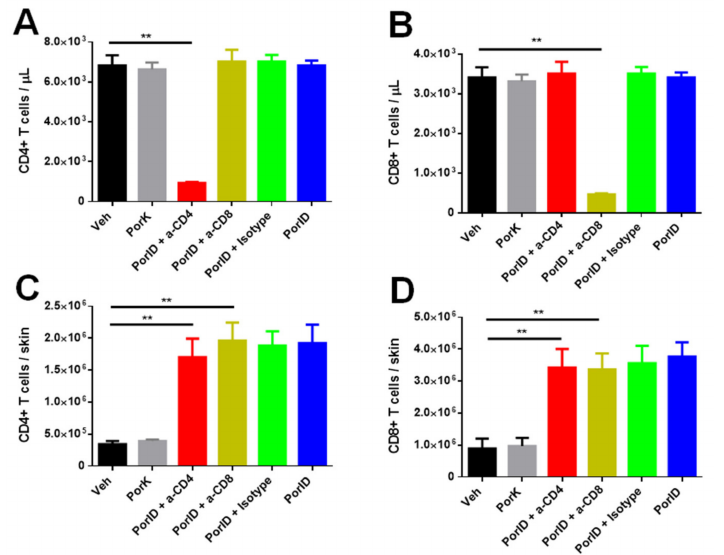
Figure A4. Only circulating memory but not resident memory CD4+ and CD8+ T cells are depleted using GK1.5 and TIB-210 antibodies. C57BL/6J mice were injected with porins intradermally at day 0 and with a homologous boost at day 14. Mice were divided into 4 conditions: anti-CD4 (a-CD4), anti-CD8 (a-CD8), isotype control (Isotype) and no treatment (PorID). At days 25, 28 and 31, CD4+ and CD8+ cells were depleted with GK1.5 and TIB-210 monoclonal antibodies, respectively, in a-CD4 and a-CD8 groups. Total number of CD4+ ( A ) and CD8+ ( B ) T cells per microliter of blood were evaluated; CD4+ ( C ) and CD8+ ( D ) T cell numbers in skin were also measured ( n = 10; 3 independent experiments; ** significant difference for a Kruskal–Wallis test ** p < 0.05 * p < 0.1 with Dunn’s multiple